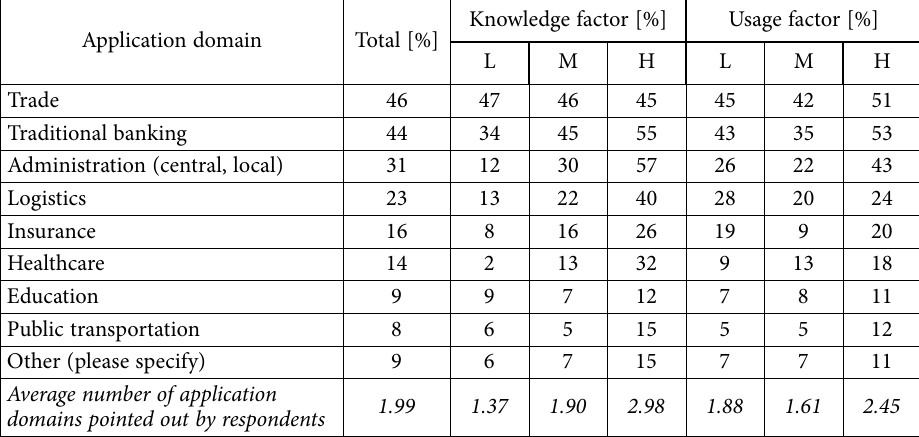
Table 7. Application domain in relation to knowledge and usage factors